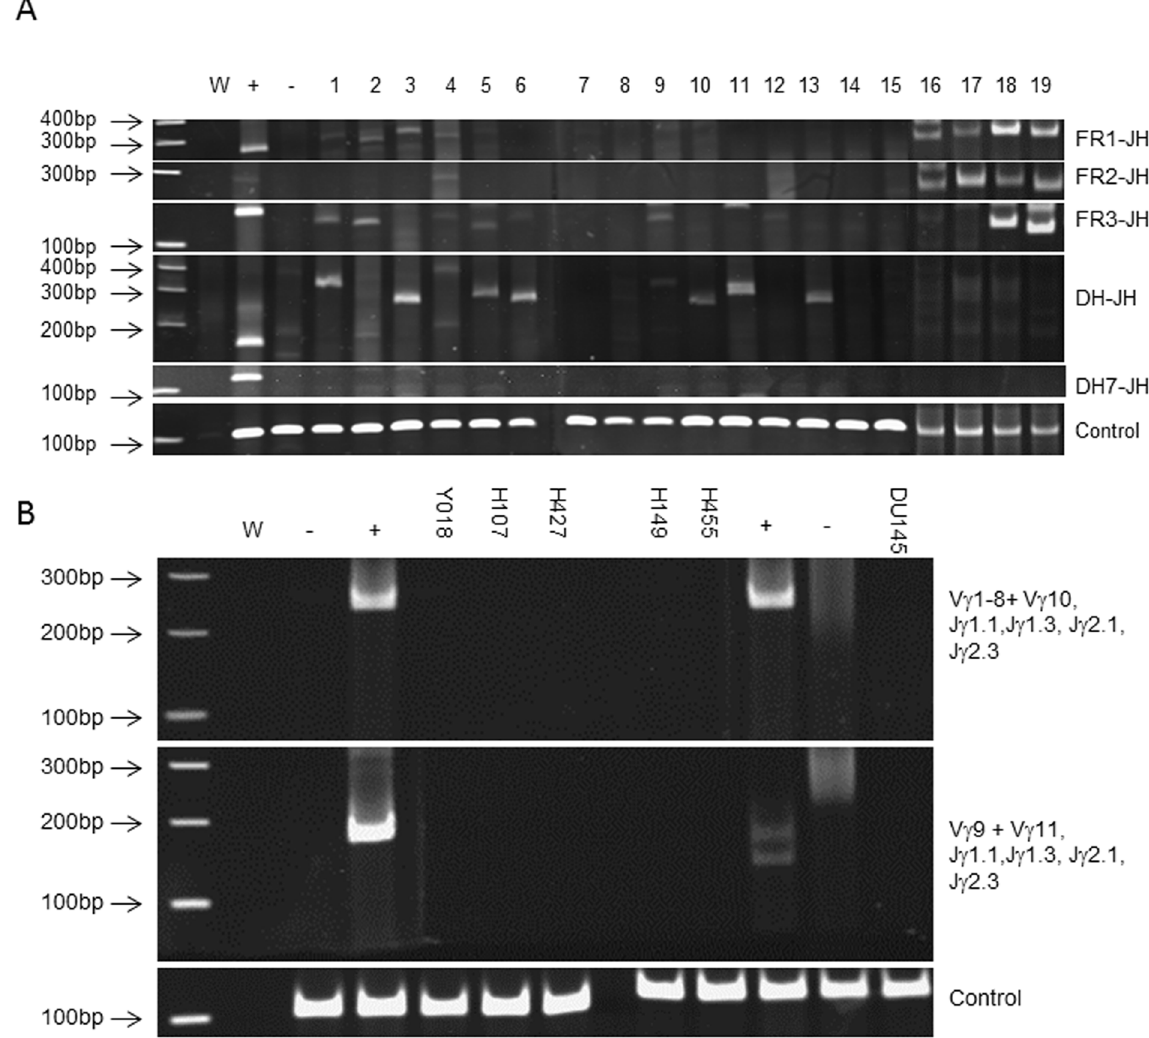
Fig 5. IGH and T cell receptor gamma chain gene rearrangements in a PDX panel. A . PCR amplification of IGH gene VJD regions using a multiplexed PCR. W = water control. + = B cell lymphomaclonal control.— = negativecontrol (prostate epithelial primary culture). Targets, FR1-JH: Y042 (L1) H016 (L2), H042 (L3), H084 (L4), H027 (L16), H288 (L17), H050 (L18), H024 (L19) are within the valid size range (310-360bp). FR2-JH: H084 (L4), H027 (L16), H288 (L17), H050 (L18), H024 (L19) are within the valid size range (250-295bp). FR3-JH: Y042 (L1), H016 (L2), H084 (L4), H082 (L5), H087 (L6), H460 (L9), Y018 (L12), H050 (L18), H024 (L19) are within the valid size range (100-170bp). DH-JH: H084 (L4), H087 (L6), H493 (L10), Y019 (L11), Y056 (L13) are within the valid size range (110–290and 390-420bp). DH7-JH:valid size range is 100-130bp B . PCR amplification of TCRG V-J regions using a multiplexed PCR. W = water control. + = Positive controls (lanes 4 & 10; T cell lymphomaclonalcontrols),— = negativecontrols (lane 3; prostate primary culture, lane 11; polyclonal control, lane 12; DU145prostate cell line). Targets, V γ 1–8+V γ 10, J γ 1.1,J γ 1.3, J γ 2.1, J γ 2.3: Valid size range 145–255bp. V γ 9+ V γ 11, J γ 1.1,J γ 1.3, J γ 2.1, J γ 2.3: Valid size range 80–220bp.